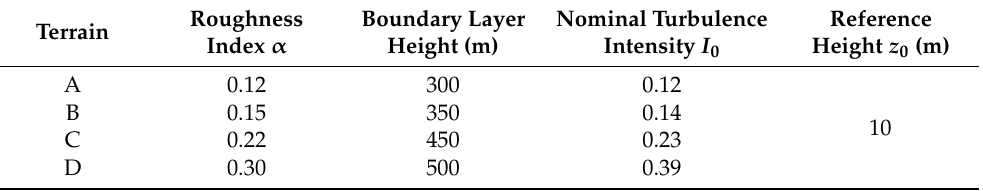
Table 1. Details of the atmospheric boundary layer parameters for the CNS